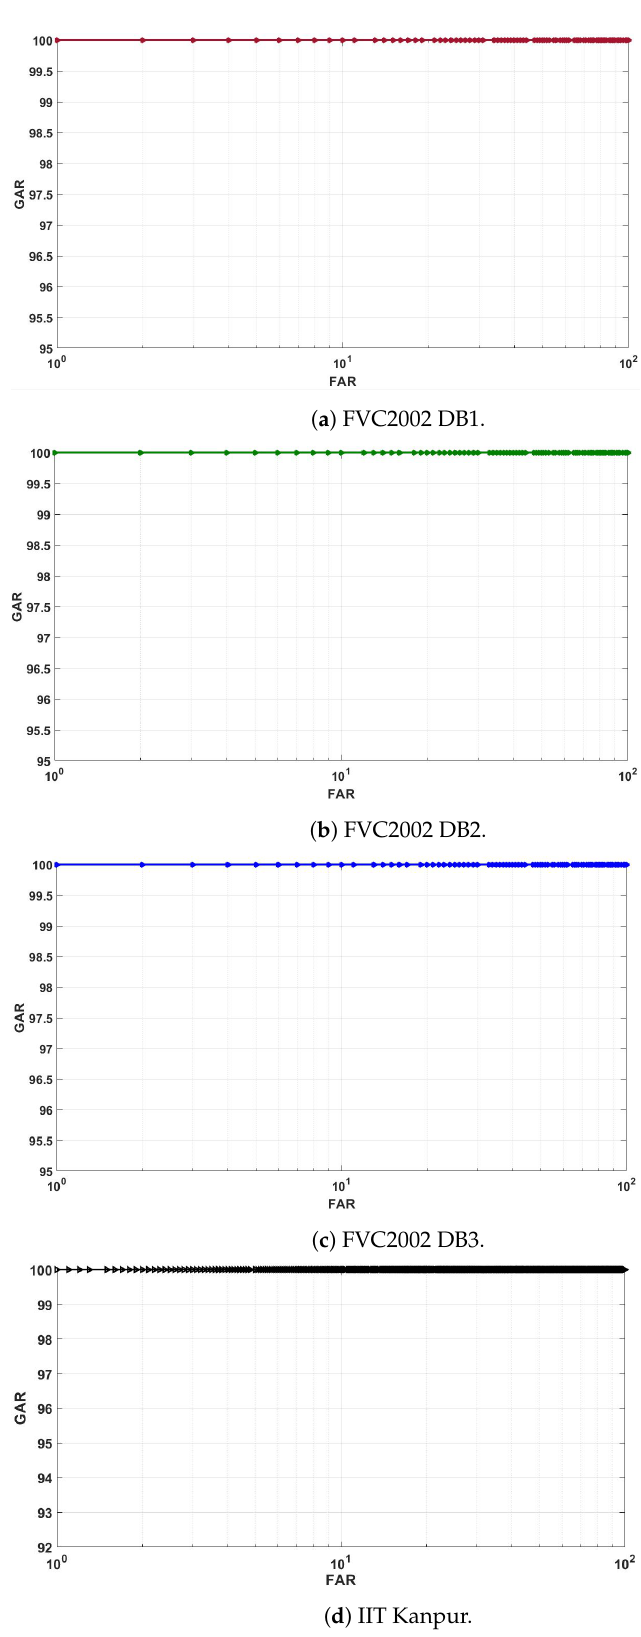
Figure 11. The proposed technique’s ROC